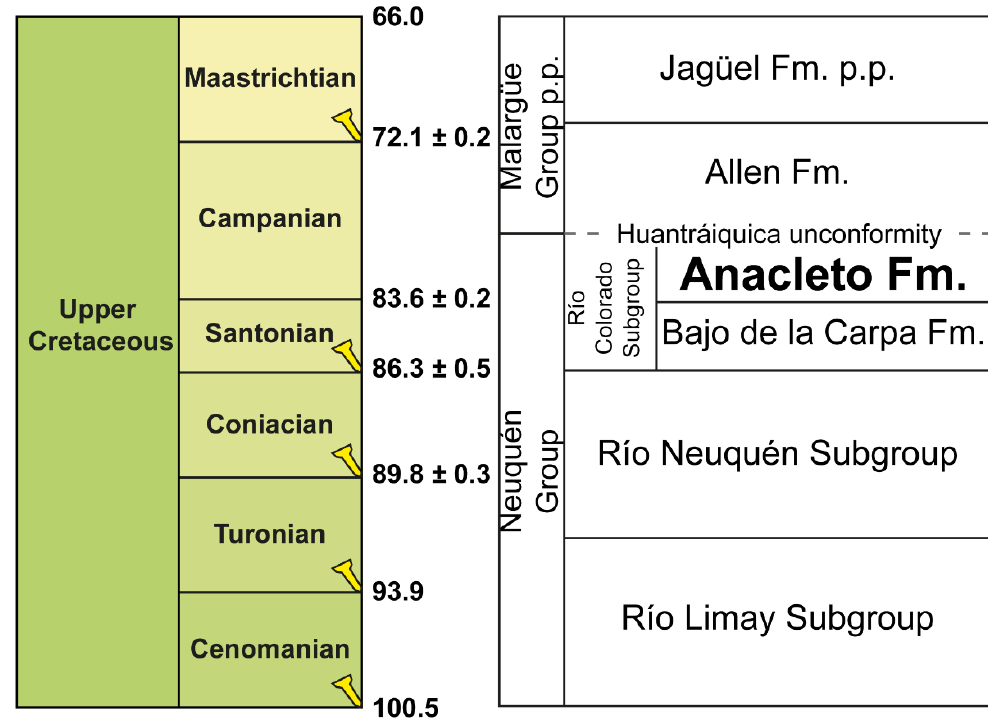
Figure 2. Chronostratigraphic scheme of the Upper Cretaceous units of the Neuquén Basin, showing the Neuquén Group and the Cretaceous portion of the Malargüe Group (redrawn and slightly modified from [7]). Absolute ages according to the International Chronostratigraphic Chart (version 2022/02 accessed on 1 February 2022; retrieved from www.stratigraphy.org).